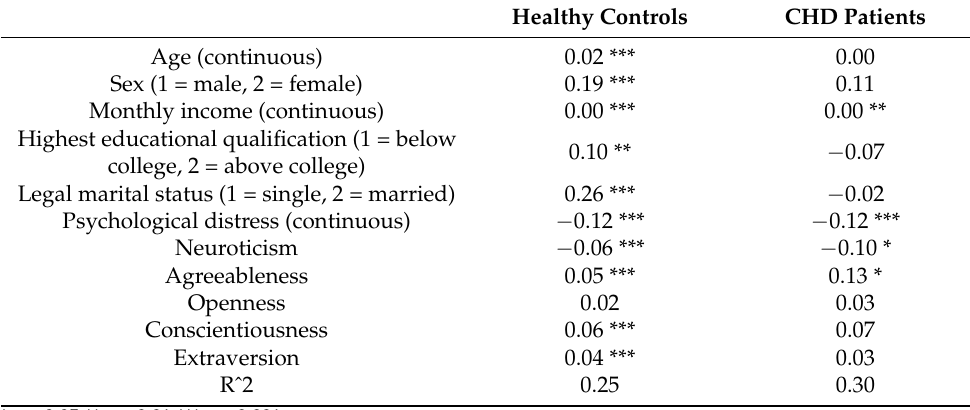
Table 2. The estimates ( b ) of multiple regression models for healthy controls and people who have been diagnosed with CHD by taking demographics, psychological distress, and personality traits as the predictors and life satisfaction as the predicted variable. All numbers are rounded up to two